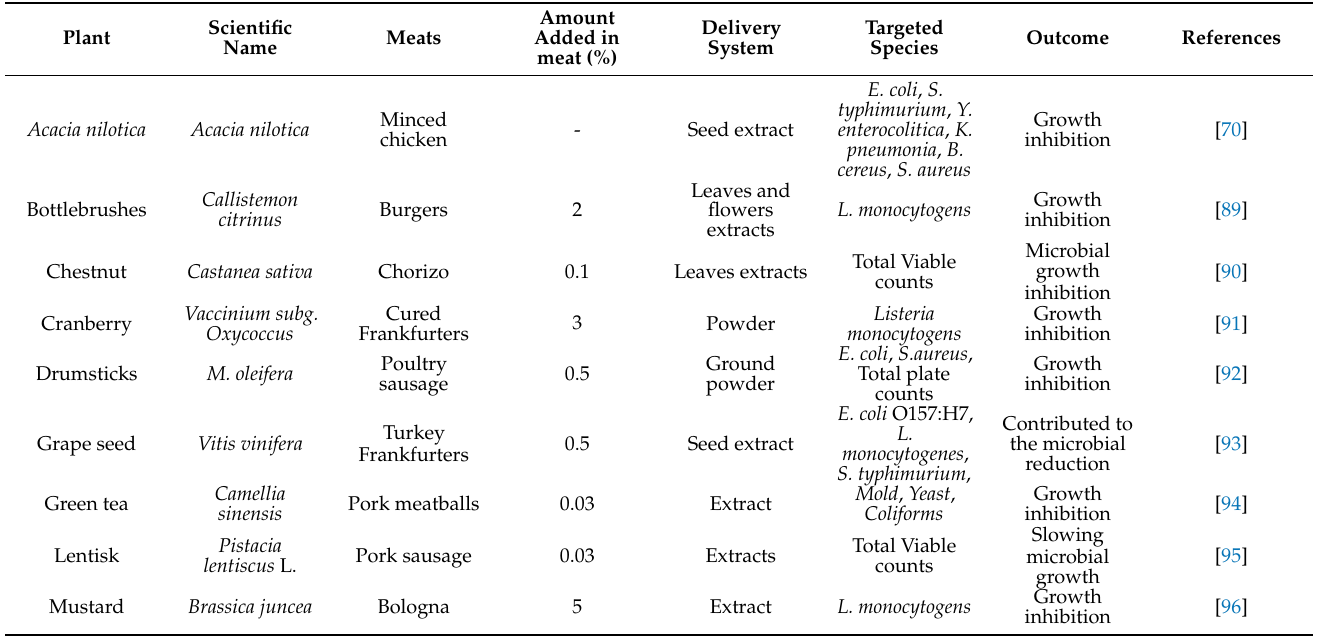
Table 2. Some studies regarding the application of phenolic-rich extracts to comminuted meat products to enhance meat